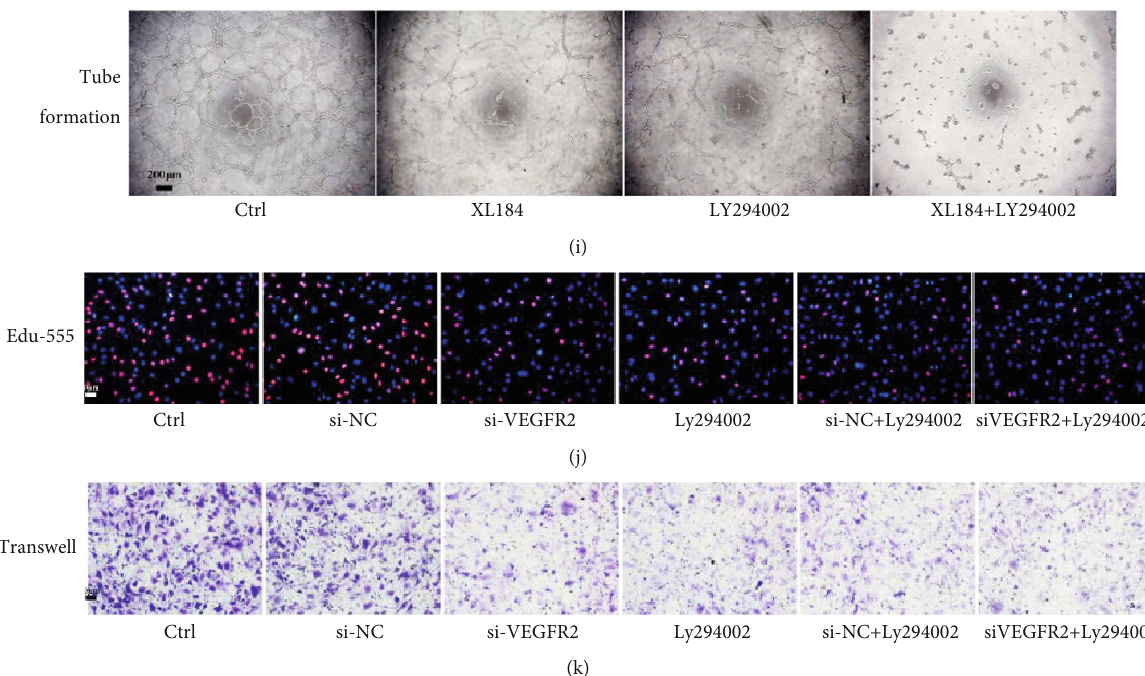
Figure 4: Inhibition of the VEGFR2/Akt/eNOS pathway attenuated CD137 signaling activation-mediated endothelial function. (a, b) The relative protein expression of p-Akt(Ser473) after treatment with di ff erent concentrations of LY294002 (0, 2.5, 5, 10, 25, 50, and 75 μ M) for 30 minutes and analyzed to β -actin. c Detection of p-VEGFR2 (Tyr1173), p-Akt (Ser473), and p-eNOS (Ser1177) proteins by western blot after treatment with VEGFR2 siRNA or/and LY294002 then activation of CD137 signaling for 10 minutes. The protein relative expression was quanti fi ed to total proteins (d). (i) The tube formation of HUVECs after treatment with VEGFR2 siRNA or/and LY294002 with the CD137 signaling activation. Scale bar = 200 μ m (e, f). (j, k) the EdU-555 proliferation assay and transwell assay were applied to detect endothelial proliferative and migratory ability. (j, k) Red and blue fl uorescence represent the proliferating cells and nuclei, respectively, and the violet color represents migrating cells stained with 0.1% crystal violet. (g, h) The numbers of proliferative and migratory ECs were analyzed with Image-Pro Plus 8.0. ∗∗∗ p < 0 : 001 . All treatments were under the circumstance of the CD137 signaling activation. Scale bar = 20 μ m , n = 3